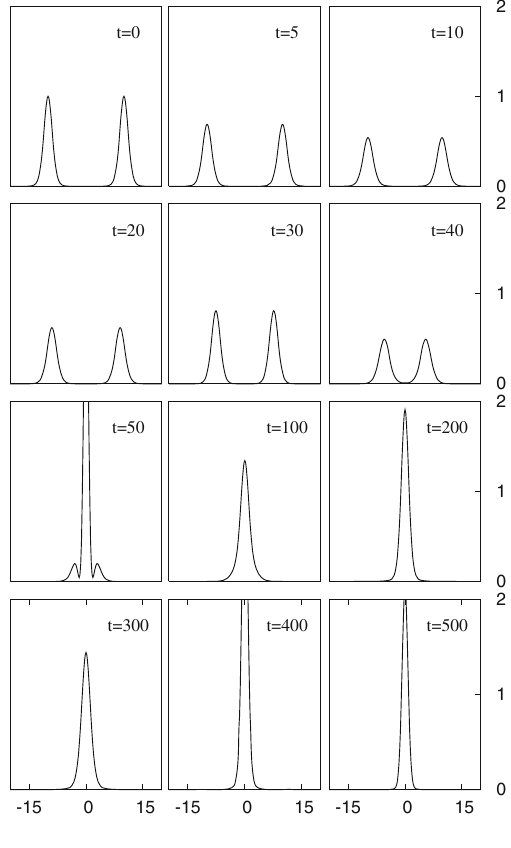
Fig. 17 Collision of identical boson stars with small kinetic energy in the Newtonian limit. The total energy is dominated by the gravitational energy and is therefore negative. The collision leads to the formation of a single, gravitationally bound object, oscillating with large perturbations. This contrasts with the large kinetic energy case (and therefore positive total energy) displayed in Fig. 16. Reprinted with permission from Bernal and Guzmán (2006a); copyright by